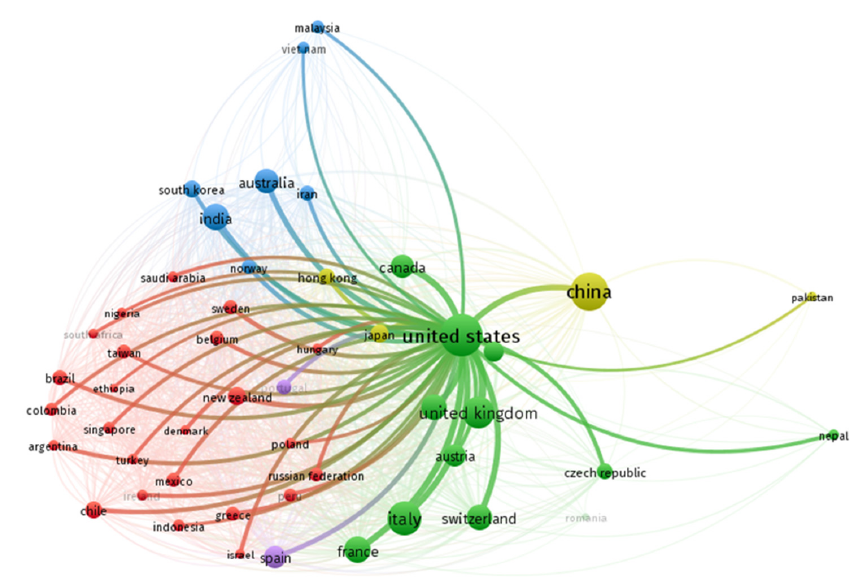
Figure 2. A bibliographic representation of the countries contributing to the physical vulnerability assessment research of debris flow hazards in the last 20 years (Vos viewer).